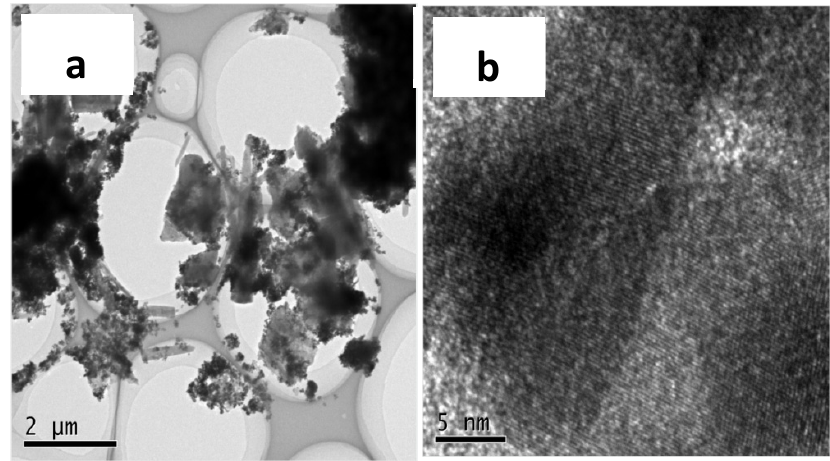
Figure 4. HR-TEM ( a ), SEM ( b ) images of g-C 3 N 4 /RGO/Fe 3 O 4 Table 1. Characterization methods of morphology, phase and composition analysis of carbon ni- tride-based photocatalytic nanocomposites.